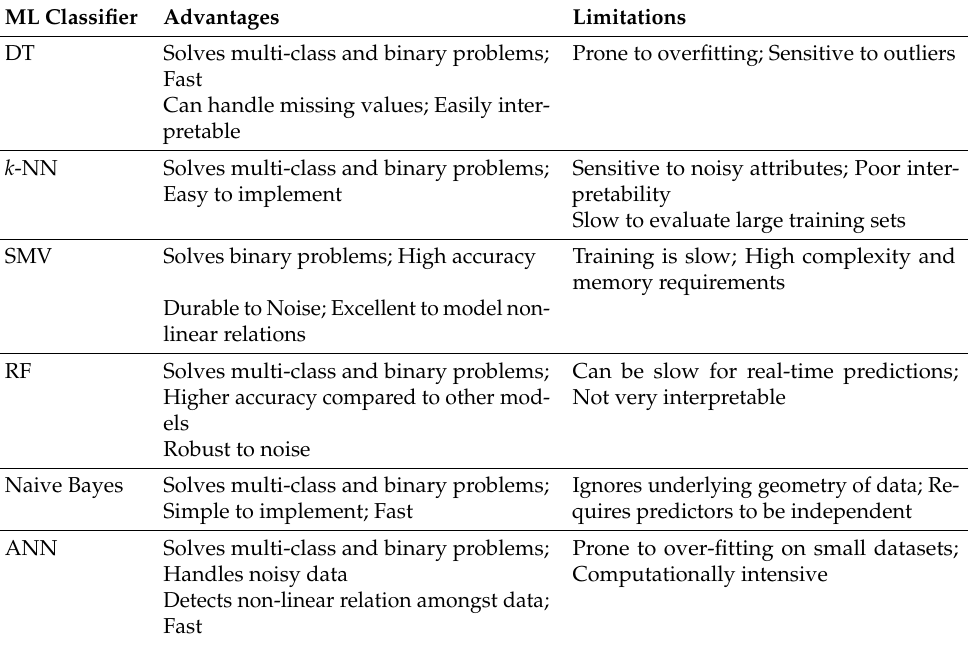
Table 1. The advantages and limitations of commonly utilized ML classifiers